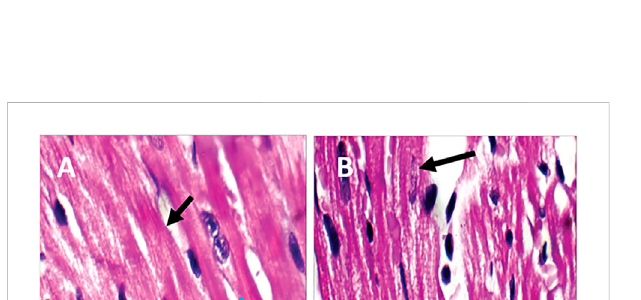
tissue of the non-diabetic rats in the negative control group (1-fold, p < 0.001). Meanwhile, prophylactic administration of the PPE induced signi fi cant a decrease in the gene expressions of lncRNA- MALAT1 and pyroptosis markers (NLRP3 and caspase-1) in the cardiac tissue of the diabetic rats (3.252 ± 0.643, 4.162 ± 0.668, and 3.534 ± 0.745 fold, respectively, p < 0.05). Our results showed that